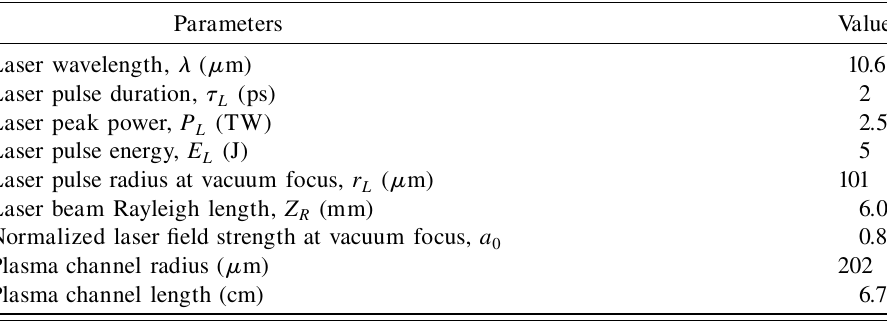
TABLE I. BNL ATF laser parameters used in the model simulation.